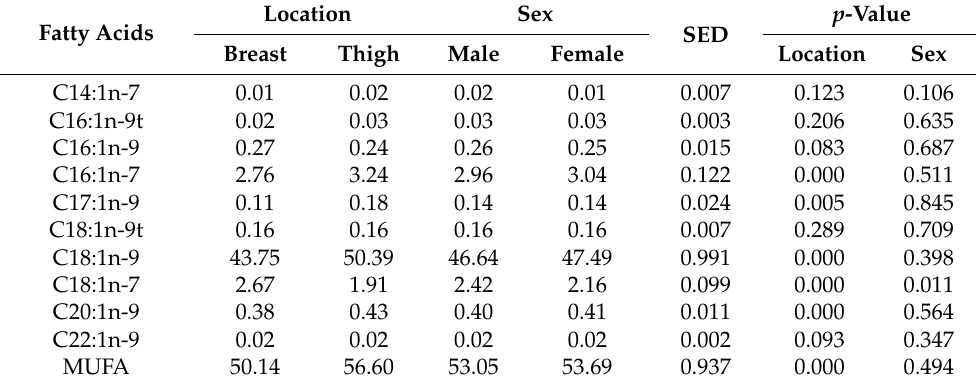
Table 9. Effects of muscle anatomical location and sex on monounsaturated fatty acid (% of total FA) composition of goose meat